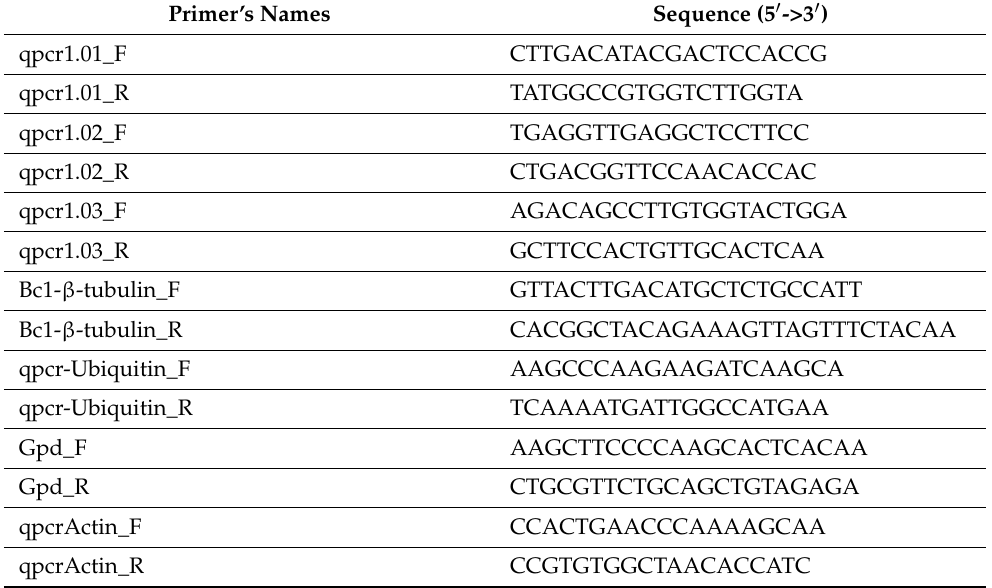
Table 1. List of all the primers used in this